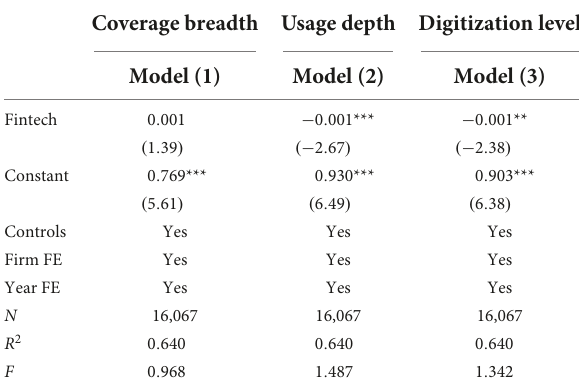
TABLE 7 Test the effect of power concentration.